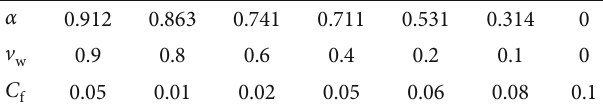
Table 3: Assumed water velocity deviation factor.